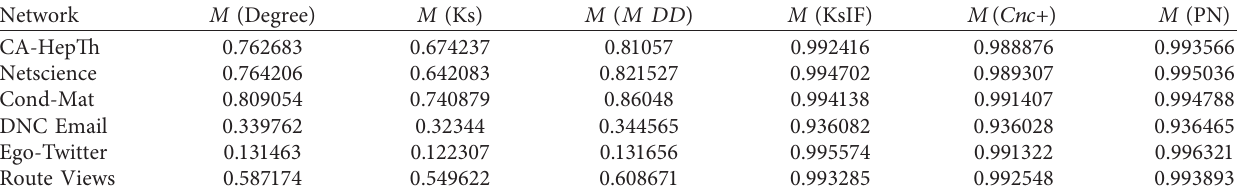
Table 3: The monotonicity M (R) of six real networks, R is representing the ranking vector of different methods.